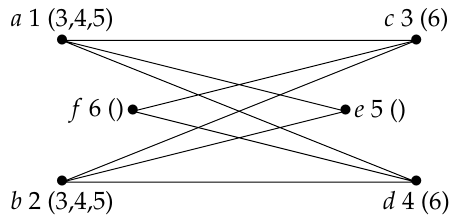
Figure 3. Lexicographic Depth-First Search (LexDFS) labels detect new cliques on the